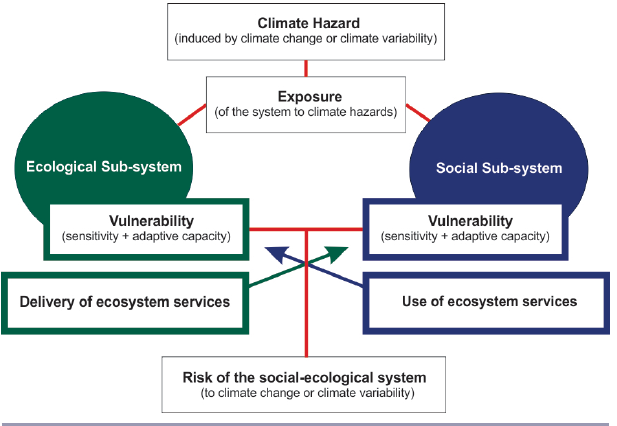
Fig. 1. Vulnerability of social-ecological systems, expressed by delivery and use of ecosystem services between social and ecological subsystems. Sources: Marshall et al. (2013), IPCC (2014), Berrouet et al. (2018), Thiault et al.